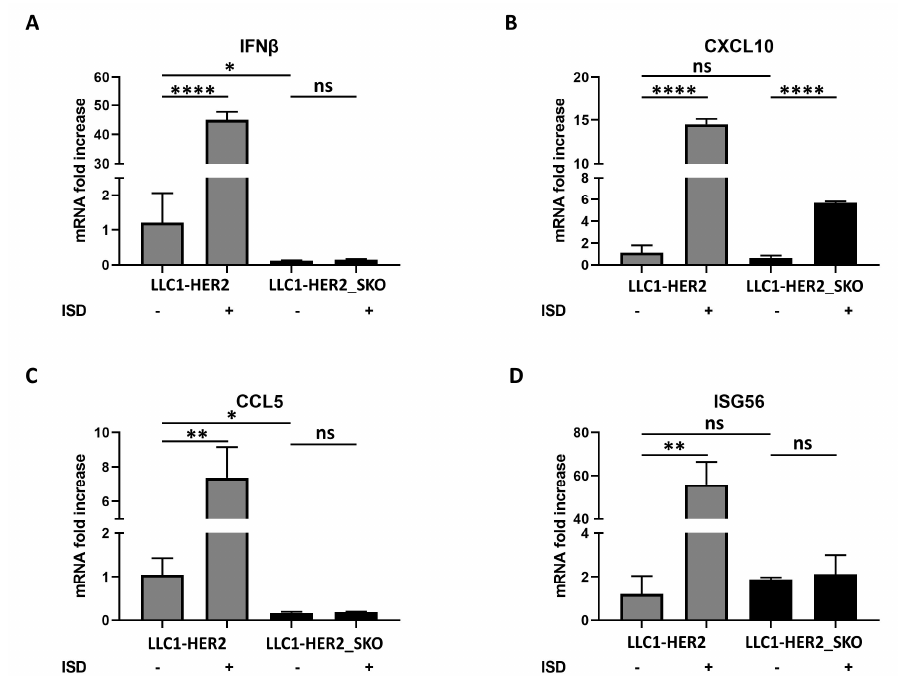
Figure 5. Induction of IFN-I cascade by DNA sensing in Sting knockout and parental cancer cell lines. LLC1-HER2 cells and Sting knockout counterparts were stimulated in vitro by interferon stimulatory DNA (ISD). Ten hours post treatment, Ifnb ( A ), Cxcl10 ( B ), Ccl5 ( C ) and Isg56 ( D ) transcripts were assessed by real-time PCR. The relative abundance of target RNAs was evaluated in relation to Actinb transcript. The statistical significances for experiments described in Figure 5 were calculated by Student’s t -test. Panel A, the p -values were 1.2E-5 comparing untreated and treated LLC1-HER2 and 0.01 comparing Sting wild-type vs. knockout cell lines. Panel B, the p -values were 1.2E-5 comparing untreated and treated LLC1-HER2 and 3E-6 comparing untreated and treated LLC1-HER2_SKO. Panel C, 0.003 comparing untreated and treated LLC1-HER2; 0.015 comparing Sting wild-type vs. knockout cell lines. Panel D, 0.0008 comparing untreated and treated LLC1-HER2. Ns indicates statistically not significant differences calculated by Student’s t-test. p <0.05 *; p <0.005 **; p <0.00005 ****.